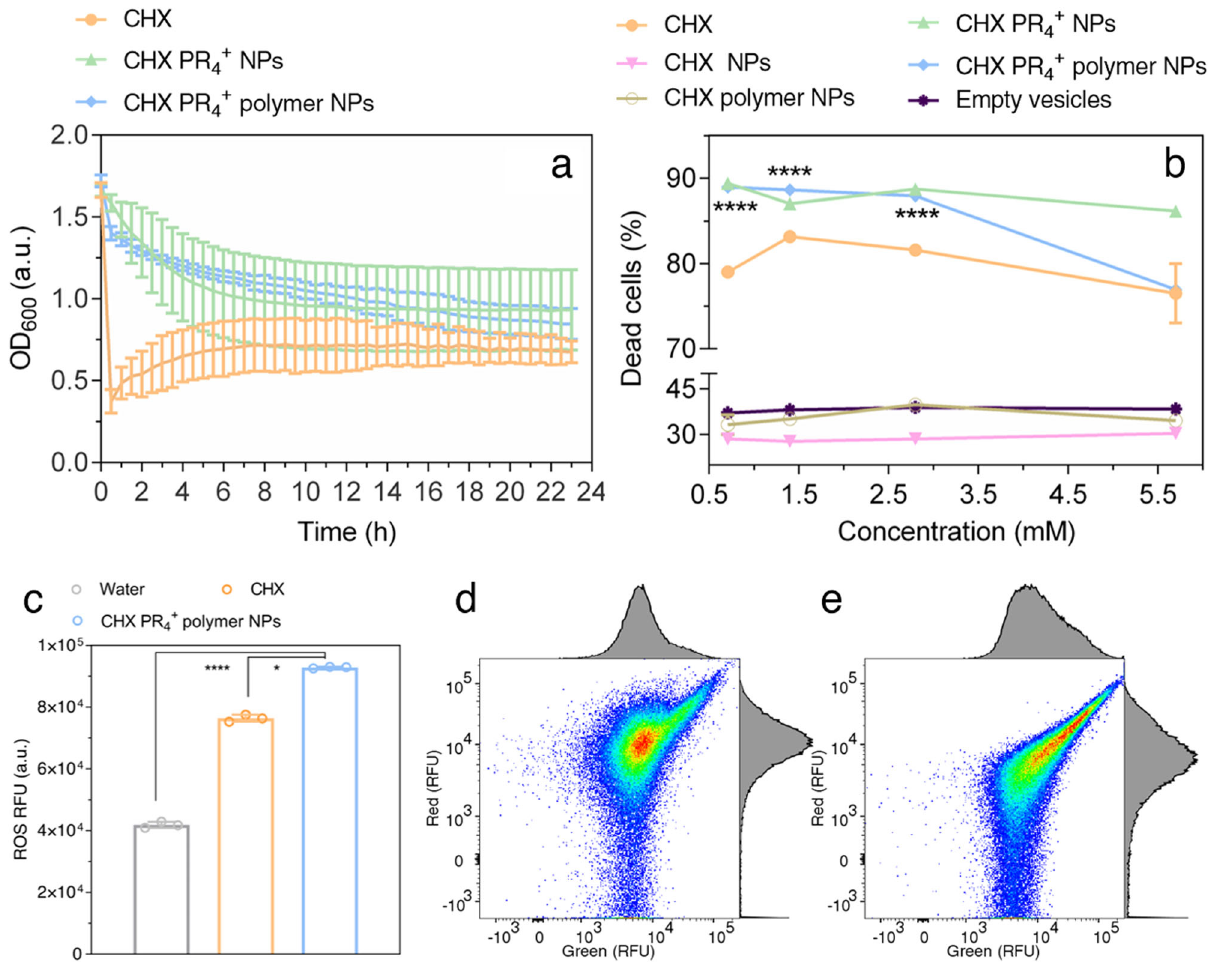
Fig. 3 The ef fi cacy of NPs against the planktonic form of S. mutans . a Turbidity time-kill assay for CHX, CHX PR 4 + NPs, and CHX PR 4 + polymer NPs showing a decreasing trend ( n = 3); b the quantitative live – dead fl uorescence assay for various formulations, n = 3, two-way ANOVA vs. CHX, p value < 0.0001 is indicated with ****; c ROS assay comparing the fl uorescence intensities after the treatment with various formulations, ordinary one-way ANOVA, n = 3, p values < 0.1 and 0.001 are indicated by * and ****, respectively ; Error bar represents mean ± SD; d , e membrane potential measurements are determined by the ratio of red: green fl uorescence in fl ow cytometry. The ratiometric parameters were 467 for d control and 204 for e treatment with CHX PR 4 + polymer